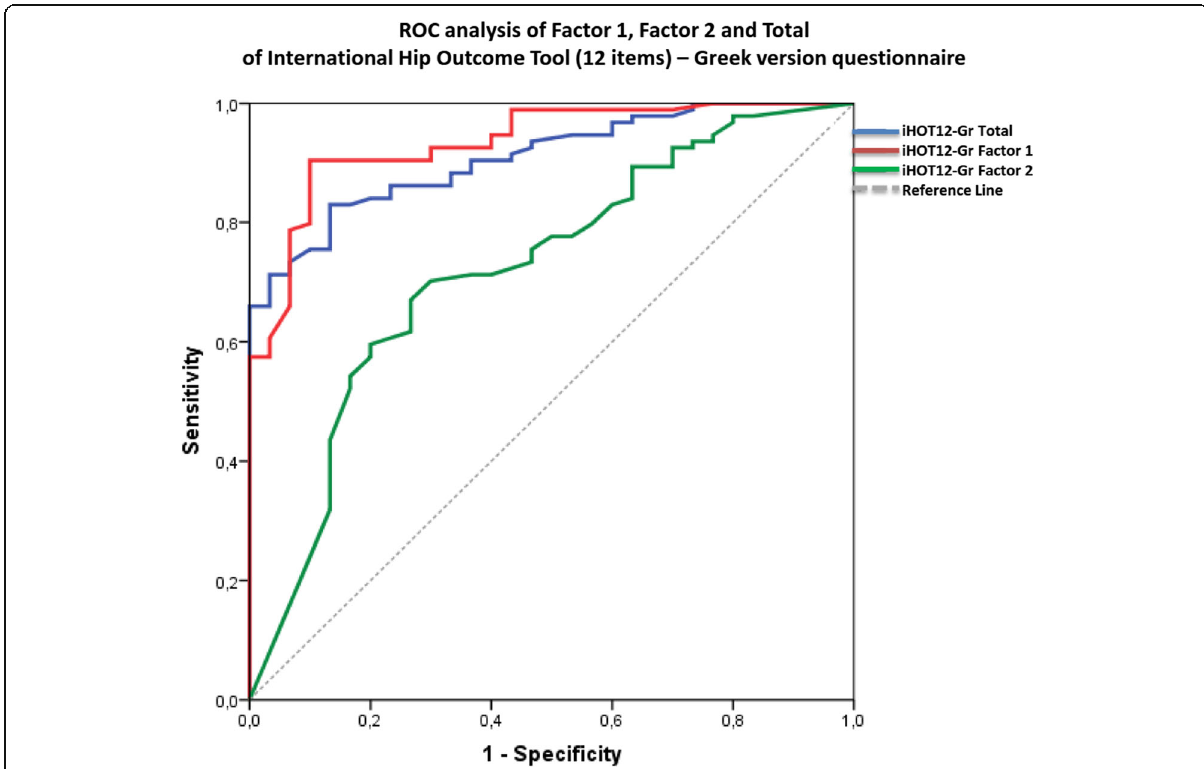
Fig. 5 In Receiver operating curve (ROC) analysis, the area under the curve (AUC) of Factor-1 was 0.935 (95% CI 0.89 – 0.98 p < 0.001) with cut-off point 51.9, sensitivity 90% and specificity 90%. The area under the curve (AUC) of Factor-2 was 0.722(95% CI 0.61 – 0.80 p < 0.001) with cut-off point 25, sensitivity 70% and specificity 70%. The area under the curve (AUC) of iHOT12-Gr-total was 0.909 (95% CI 0.86 – 0.96 p < 0.001) with cut- off point 45.2, sensitivity 83% and specificity